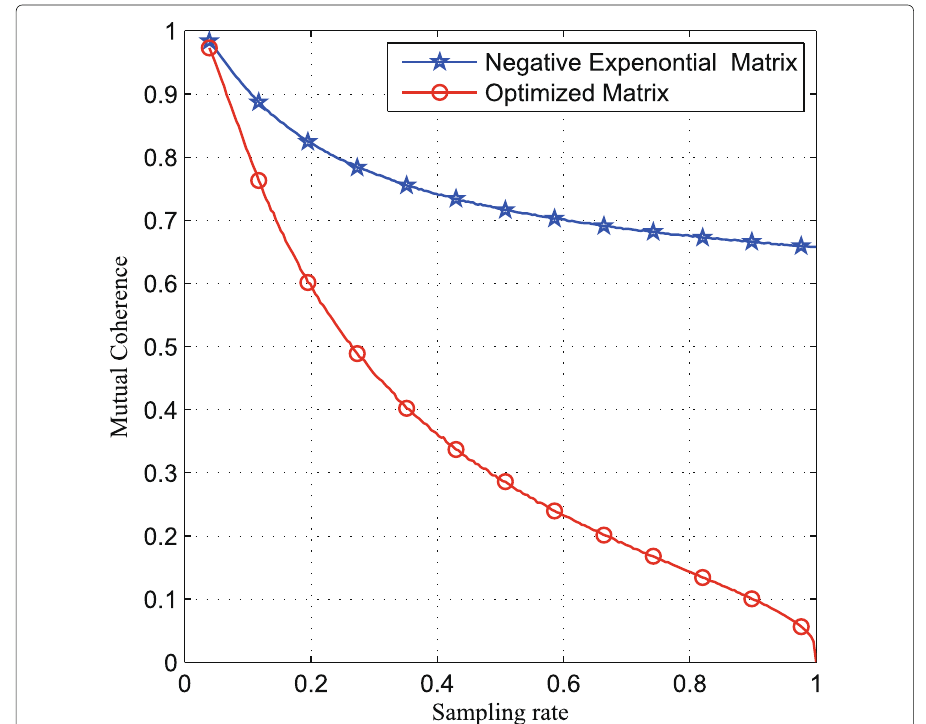
Fig. 1 μ comparsion. Mutual coherence as a function of sampling